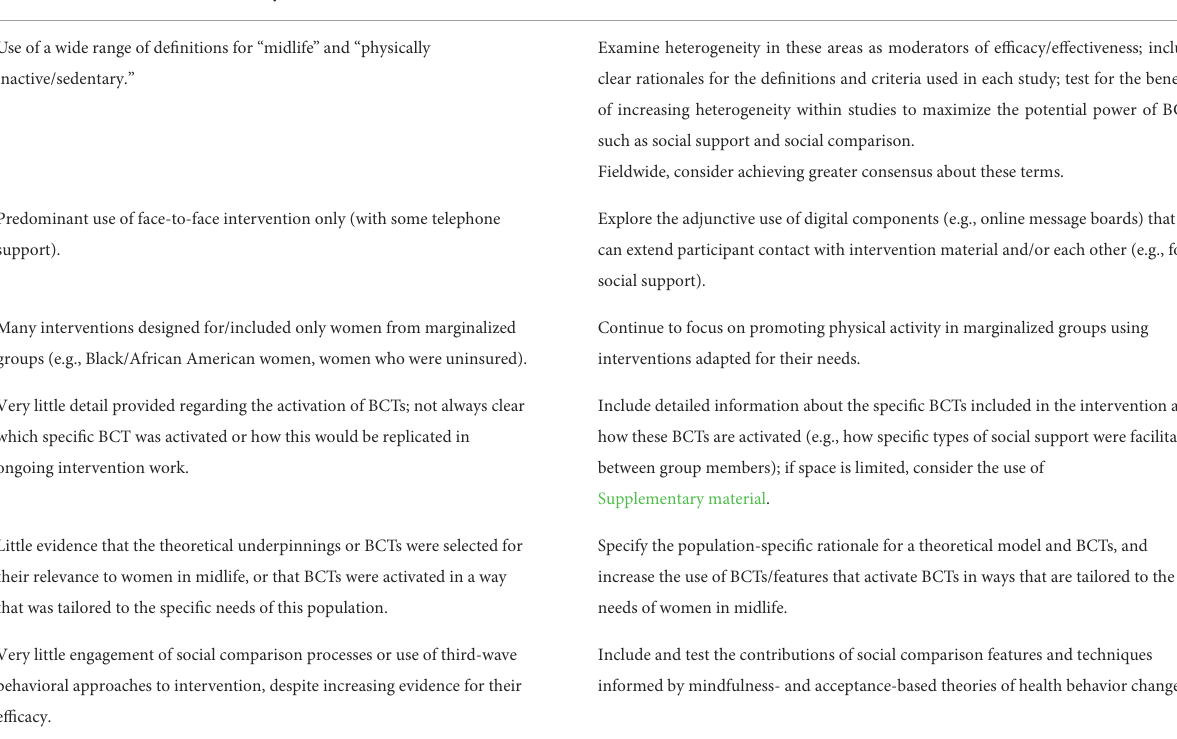
TABLE 1 Summary of key takeaways from the present review and recommendations for future research on physical activity interventions for women in midlife. Observation from literature